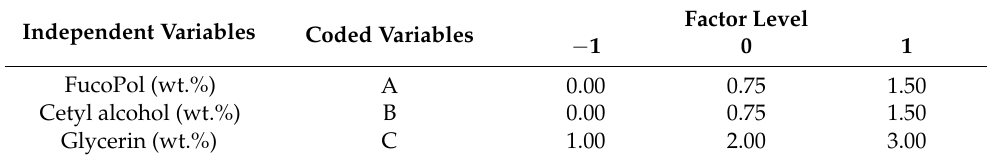
Factor Level − 1 0